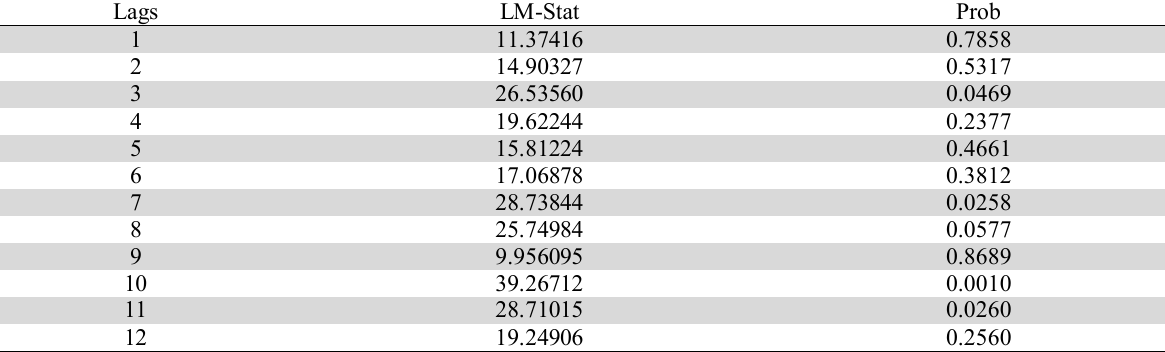
The summary of testing autocorrelation effect